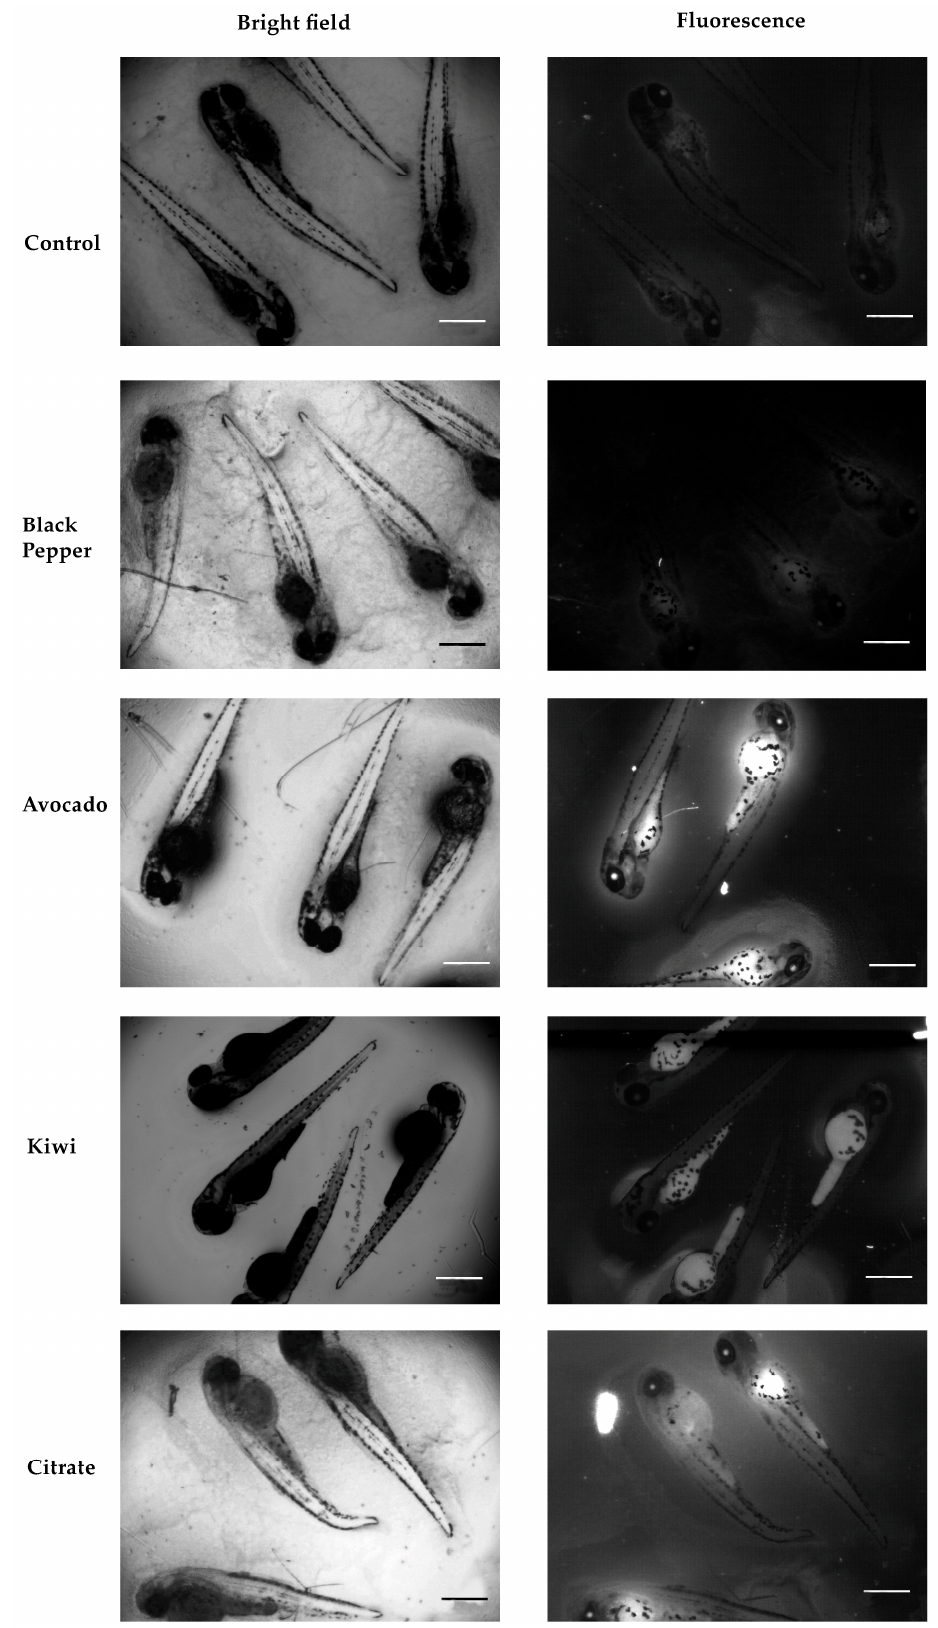
Figure 7. Bright field (left panel) and fluorescence images (right panel) of 80 h old zebrafish embryos after incubation for 2 h with 1 mg mL − 1 except for black pepper, which concentration was 0.5 mg mL − 1 . Scale bars = 500 µ